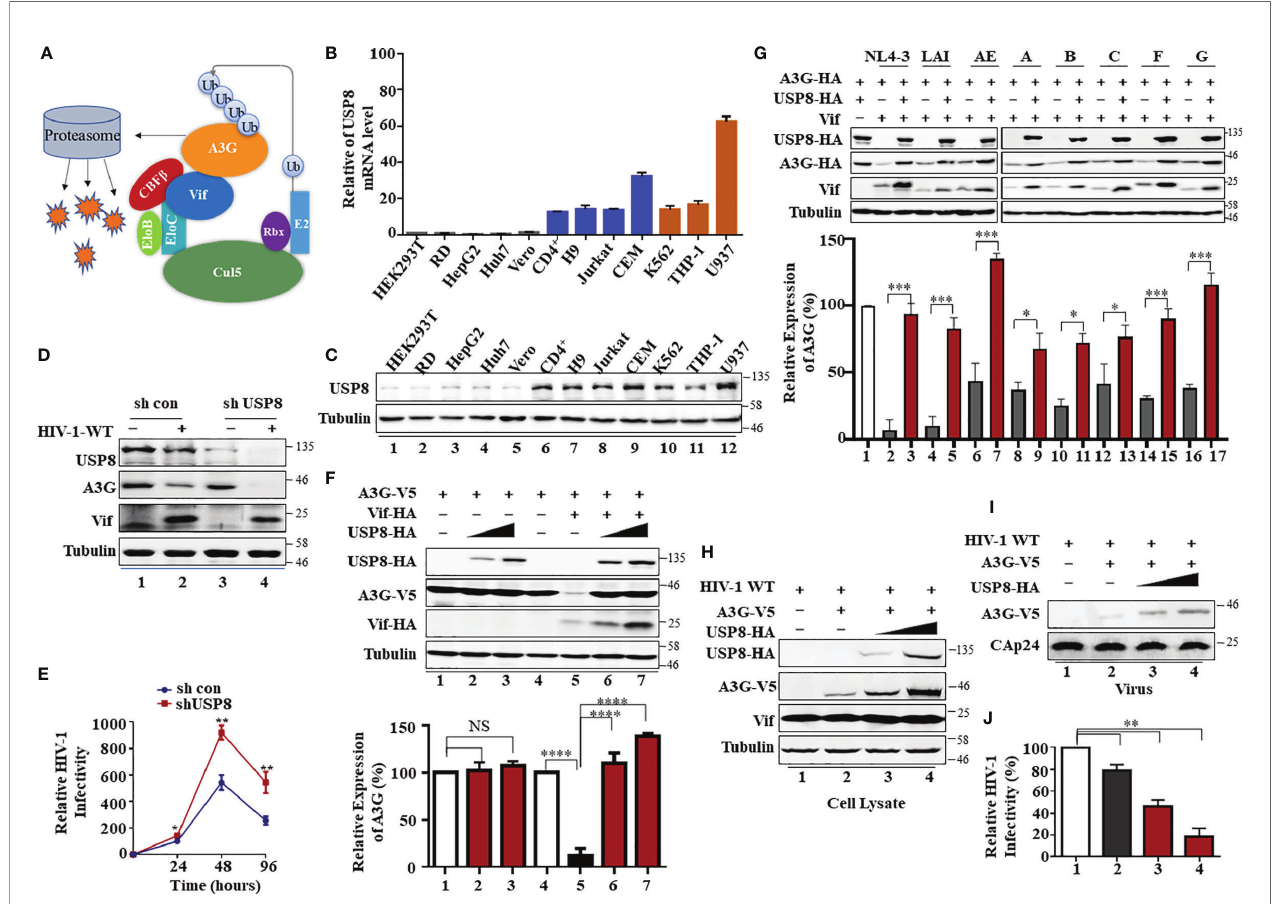
FIGURE 1 | T cell-speci fi c ubiquitin-speci fi c protease 8 (USP8) inhibits virion infectivity factor (Vif)-induced apolipoprotein B mRNA-editing enzyme catalytic polypeptide-like 3 (APOBEC3)G (A3G) degradation and suppresses wild-type (WT) HIV-1 infectivity. (A) A model of HIV Vif assembly with the Cul5, CBF b , and EloB/ C E3 components to mediate polyubiquitination and degradation of the A3G protein. (B) USP8 mRNA expression levels in various cell types were detected by RT- qPCR. USP8 mRNA expression in HEK293T cell line was set to 1.0. Glyceraldehyde 3-phosphate dehydrogenase (GAPDH) was used as a loading control. Orange, myeloid cell lines; blue, CD4 + T cell lines; black, other cell lines. (C) USP8 protein expression levels in various cell types were detected by immunoblotting. (D) The effect of USP8 silencing on A3G expression in HIV-1-infected H9 cell. H9 USP8 silencing cells were infected with HIV or not for 48 h. Endogenous USP8 and A3G were analyzed by immunoblotting. Virus infection was determined by Pr55Gag. (E) The effect of USP8 silencing on HIV infectivity in H9 cell. USP8 silencing and its control H9 cells were infected with HIV for 30 h. The cells were then washed three times with phosphate buffered saline (PBS) and placed in fresh RPMI-1640 medium with 10% fetal bovine serum (FBS). Cell supernatants were then harvested after 24, 48, and 96 h of infection. Virus infectivity was assessed using TZM-BL indicator cells. (F) USP8 inhibits Vif-mediated A3G degradation. HEK293T cells were transfected with A3G-HA and Vif-HA or its empty vector in the presence of increasing amounts of USP8-HA. Cells were harvested 48 h after transfection. Protein expression in the cell lysates was analyzed by immunoblotting with anti-HA antibody targeting USP8-HA, A3G-HA, and Vif-HA proteins. Tubulin was used as a loading control. Quanti fi cation of A3G expression was analyzed by ImageJ2X. A3G expression alone was normalized to 100%. (G) USP8 repressed the anti-A3G activity of Vif molecules from diverse HIV-1 subtypes. HEK293T cells were transfected with A3G-HA and diverse HIV-1 Vif subtypes or empty vector in the presence or absence of USP8. Cells were harvested 48 h after transfection, and protein expression in the cell lysates was analyzed by immunoblotting with anti-HA antibody targeting USP8-HA, A3G-HA, and anti-Vif antibody targeting Vif proteins. Tubulin was used as a loading control. Quanti fi cation of A3G expression was analyzed by ImageJ2X. A3G expression alone was normalized to 100%. (H – J) HIV-1 infectivity was signi fi cantly reduced when USP8 was co-expressed with A3G. WT HIV-1 and A3G-HA or control vector were co-transfected into HEK293T cells with increasing amounts of USP8-HA. After 48 h, cells were harvested, and protein expression was analyzed by immunoblotting with anti-Pr55Gag and anti-HA